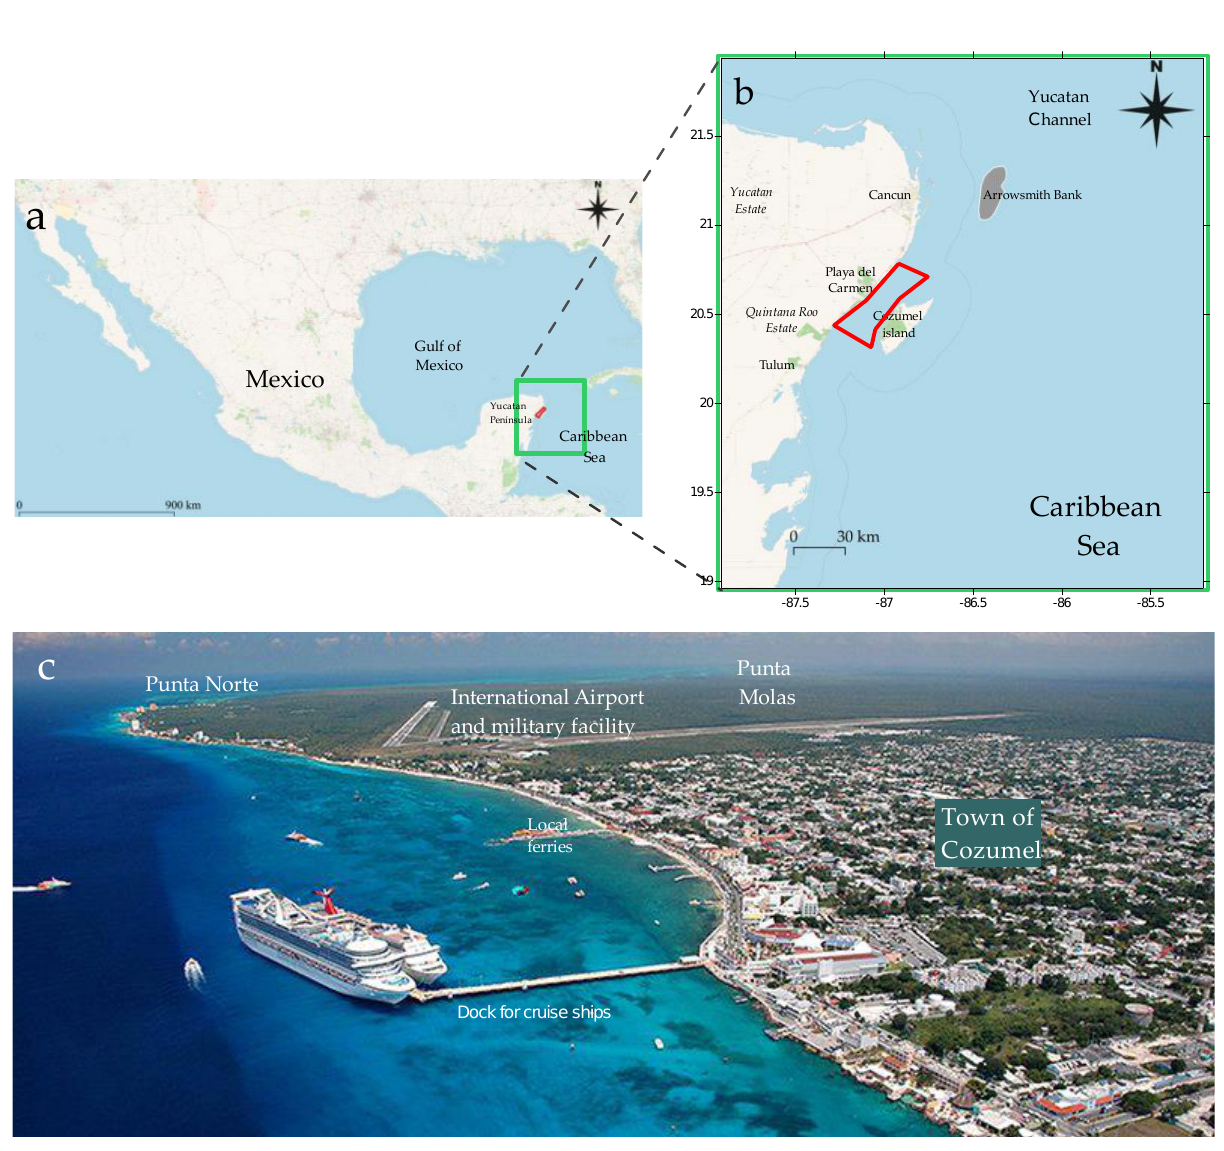
Figure 1. ( a ) The Peninsula of Yucatán, Mexico. ( b ) The study area, shown by the red polygon. ( c ) Aerial view from the NW coast of Cozumel island.